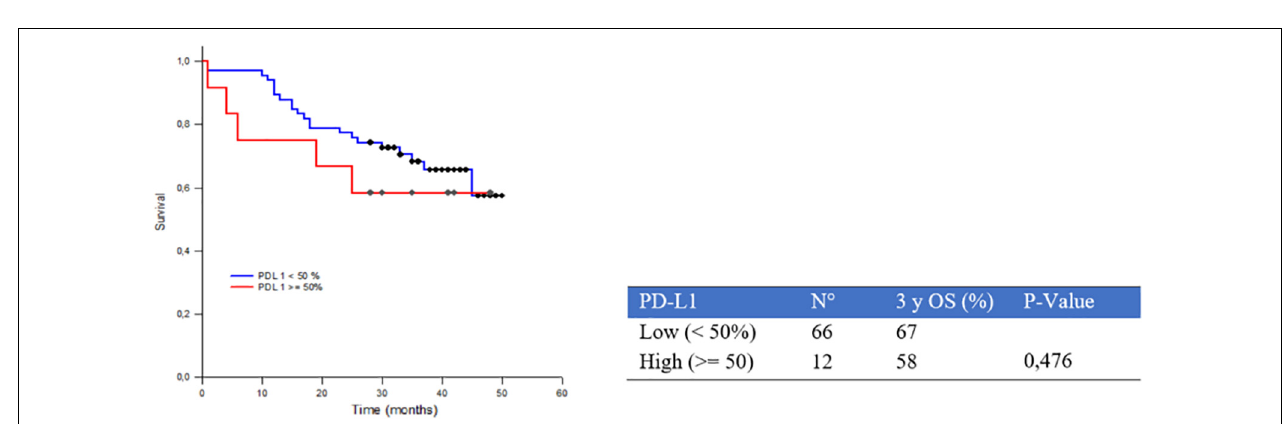
FIGURE 2 | Three-year survival rate (3yOS) data and curves according to II, IIIA, and IIIB Tumor, Node, Metastasis (TNM)-pStage.